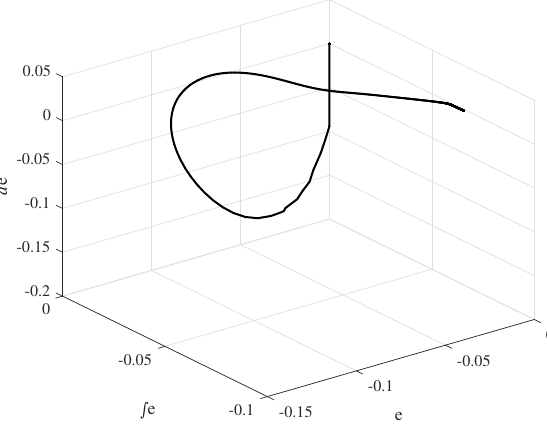
(cid:82) e -˙ e under load shedding.